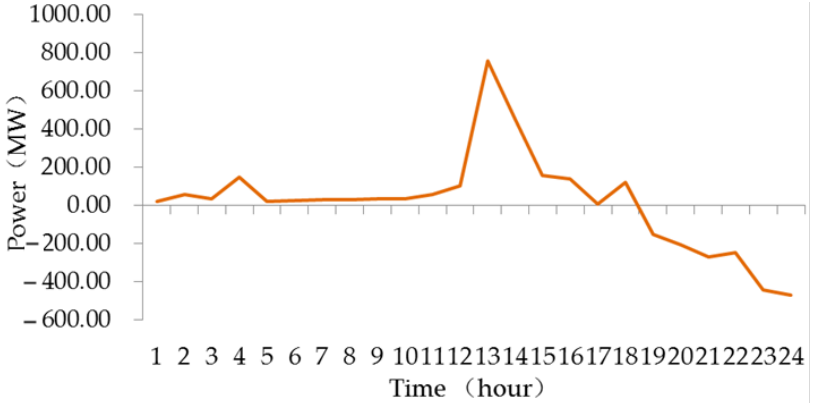
Figure 7. Pumped storage power outputs in Case 1.